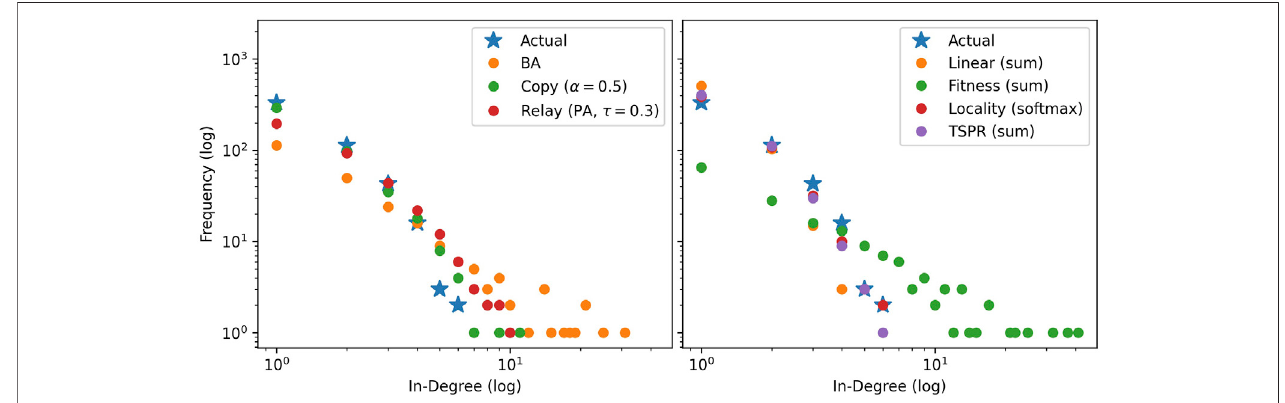
FIGURE 3 | Mode-averaged in-degree distributions for USSC-calibrated baselines (left) and subject models (right) relative to the actual. Mirroring the actual network, 50 iterations of 2000 node steps are run per model. Models in the same iteration use identical, pre-drawn out-degree counts from | E n | ∼ Po ( 0 . 388 ) and subjects from ϕ ∼ Dir ( ψ us , 14 ) , mirroring the USSC network ’ s actual properties.